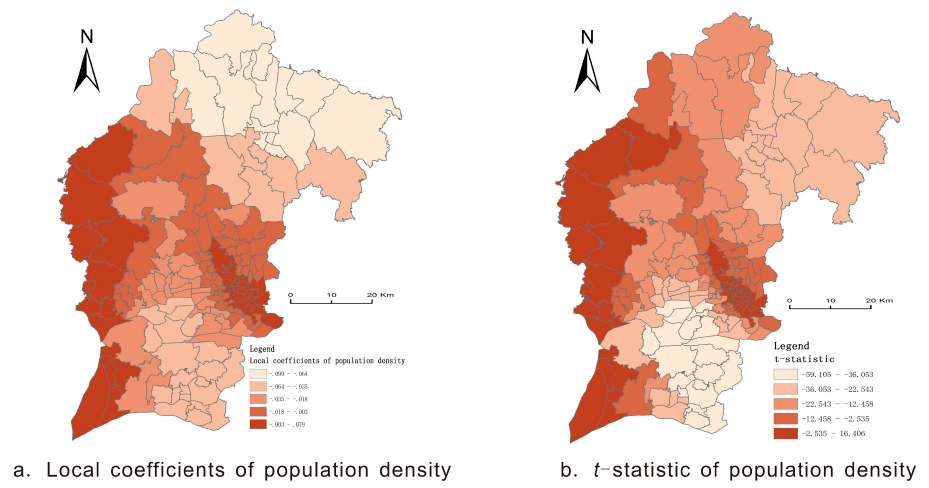
Figure 9. Distribution for local regression coefficients and t -statistics of population density.